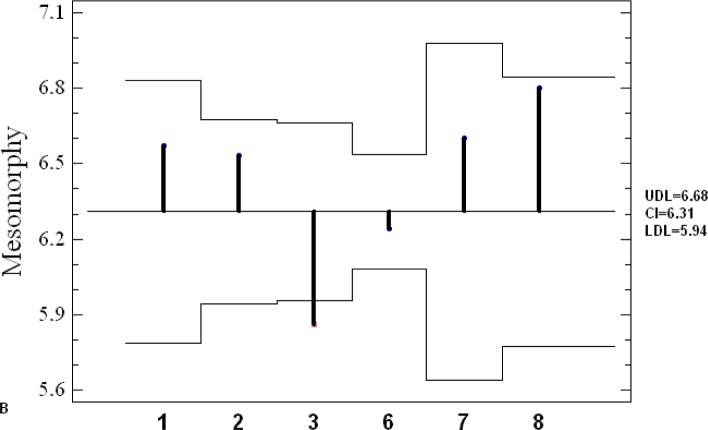
Analysis of means plot of mesomorphy with 95% decision limits. UDL - upper decision limit, CL -central line, LDL - lower decision limits5A-C.
Mean analysis (ANOM): 1-POL Present study; 2- Cuba, Betancourt, 2002; 3-POL 1993-95, Krawczyket al, 1997; 6-POL 1990, Charzewskiet al., 1991; 7- Cuba 1976-80, Rodriguez et al., 1986; 8-Czechoslovakia1973, Stepnickaet al., 1976